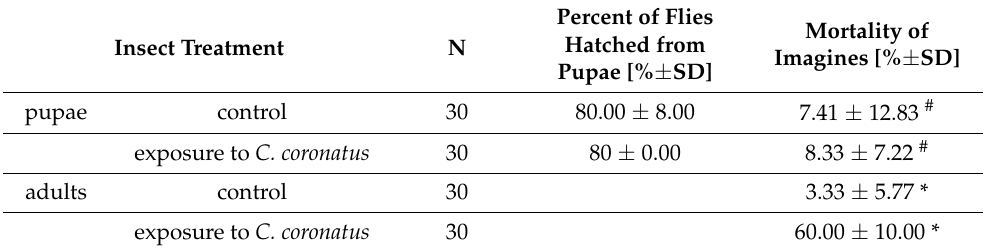
Percent of Flies Mortality of Hatched from Imagines [% ± SD] Pupae [% ± SD]